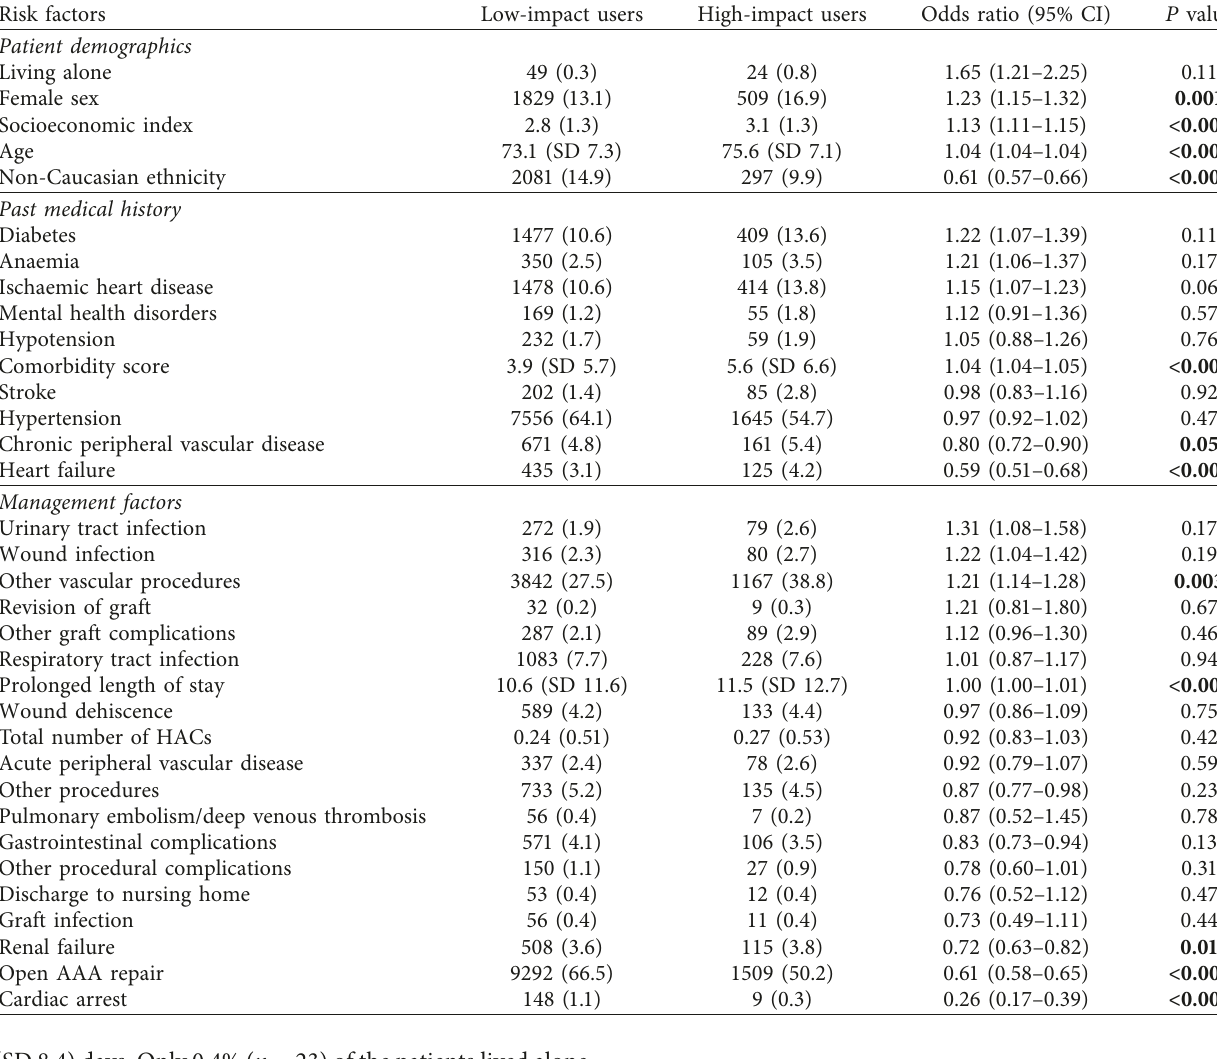
Table 1: Covariates associated with high-impact users compared to low-impact users among patients who had elective AAA repair.